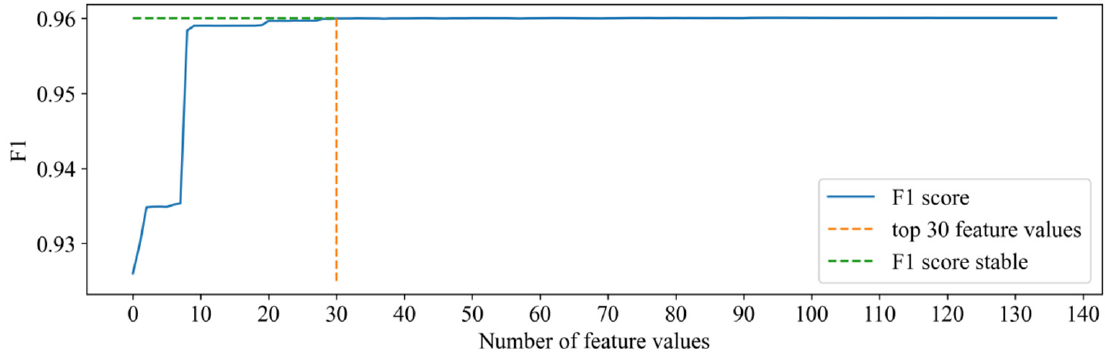
Figure 4. F1 score for dark spot segmentation using various feature-value combinations. Table 2. A subset of features obtained for dark spot segmentation using the SVM-RFE algorithm.